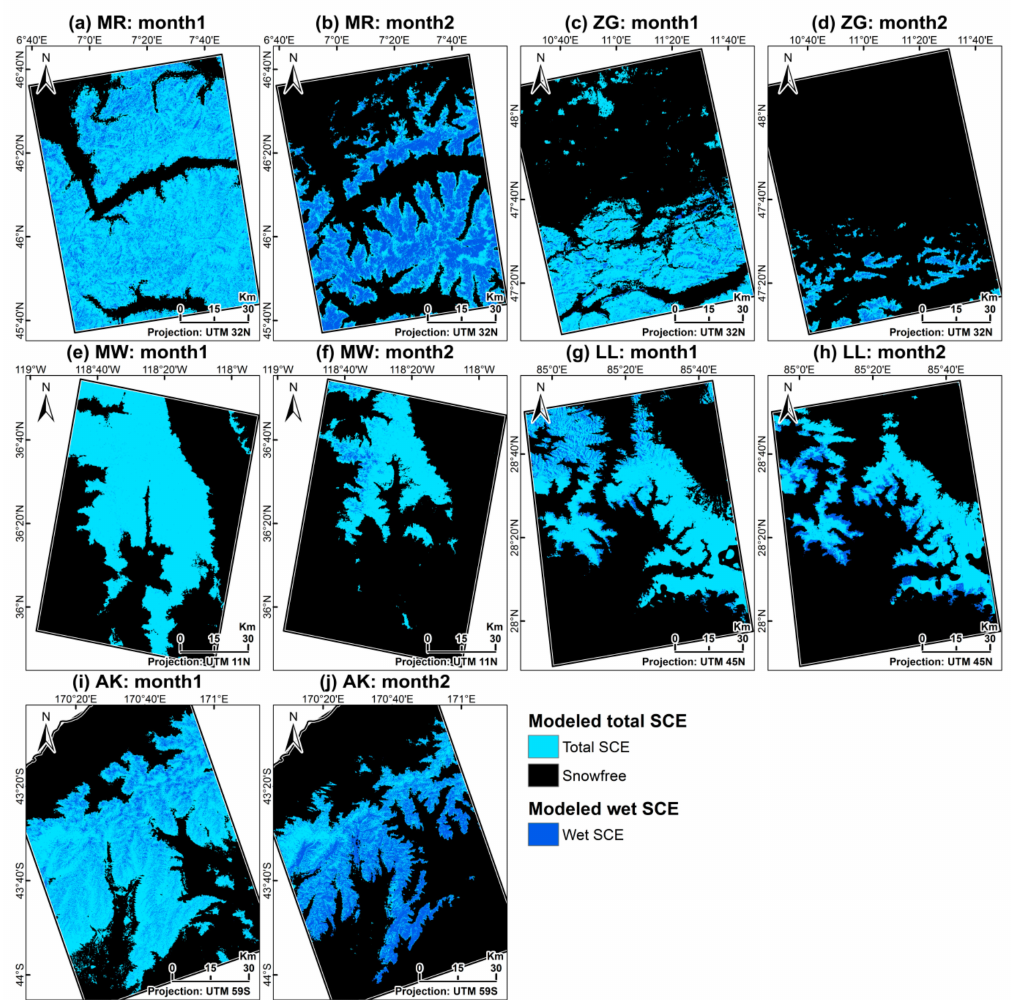
Figure 6. Total and wet SCE for two months of each region: ( a ) Monte Rosa (MR), month 1 (Mar 24, 2018); ( b ) Monte Rosa, month 2 (May 23, 2018); ( c ) Zugspitze (ZG), month 1 (Mar 26, 2018); ( d ) Zugspitze, month 2 (May 13, 2018); ( e ) Mount Whitney (MW), month 1 (Mar 16, 2018); ( f ) Mount Whitney, month 2 (May 03, 2018); ( g ) Landtang Lirung (LL), month 1 (Mar 12, 2018); ( h ) Landtang Lirung, month 2 (May 11, 2018); ( i ) Aoraki (AK), month 1 (Jun 30, 2018); ( j ) Aoraki, month 2 (May 01,